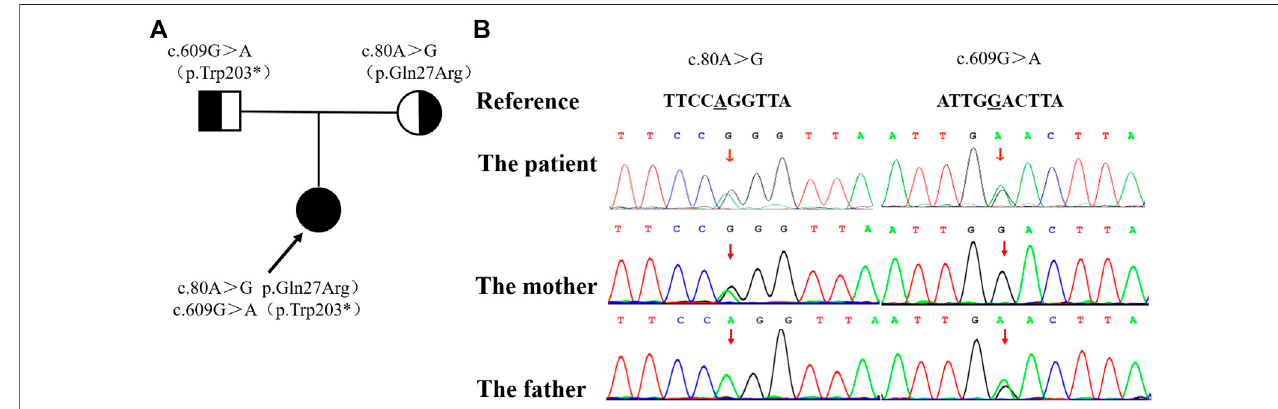
FIGURE 2 | The family pedigree showing the mutations detected in MMACHC . (A) The pedigree of the family with MMA. The arrow indicates the proband; her parentshavenosignsofMMA. (B) Themutationsdetectedinthefamily.Theprobandhasbothmutations,whilethec.80A > Gmutationwasonlydetectedinhermother and the c. 609G > A mutation was only detected in her